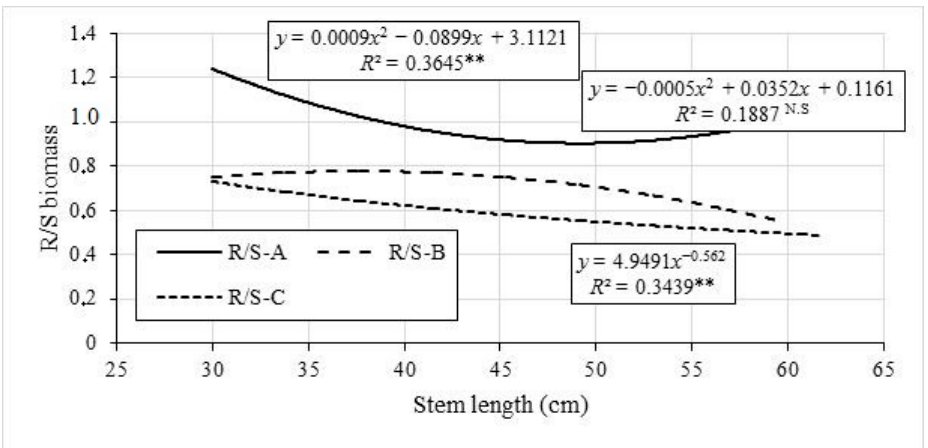
Forests 2019 , 10 , x FOR PEER REVIEW Figure 10. Relationship between stem length and R / S biomass of maple seedlings in three areas (R / S: ratio between dry biomass of root and stem; A: control area; B: Log skidded area; C: Tire track area).